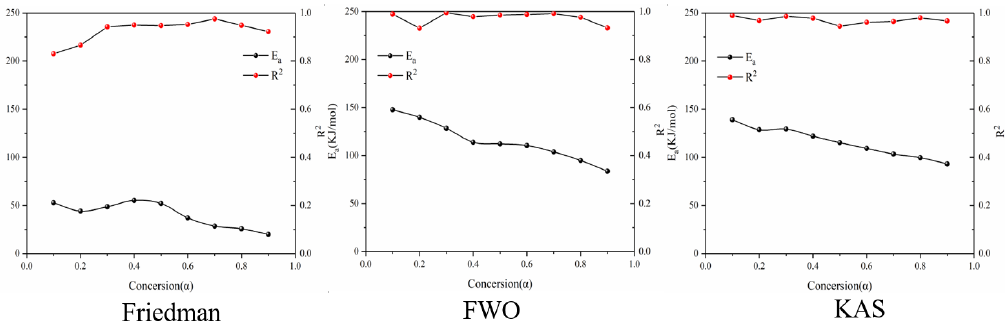
Figure 7. Ea and R 2 of three model-free methods in the second stage of battery material pyrolysis. Table 2. Ea and R 2 of three model-free methods at different conversion rates in the second stage of pyrolysis kinetics of battery materials.